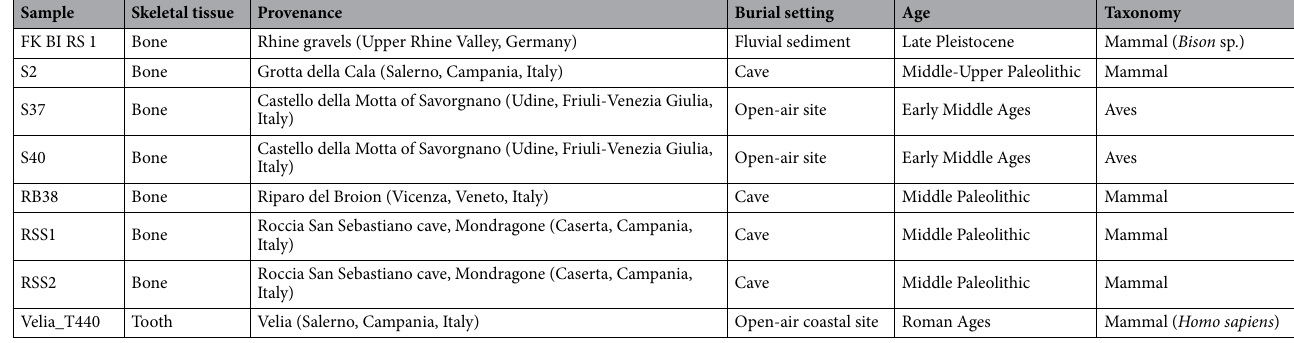
Table 1. Bone and tooth samples analyzed in this study with relevant